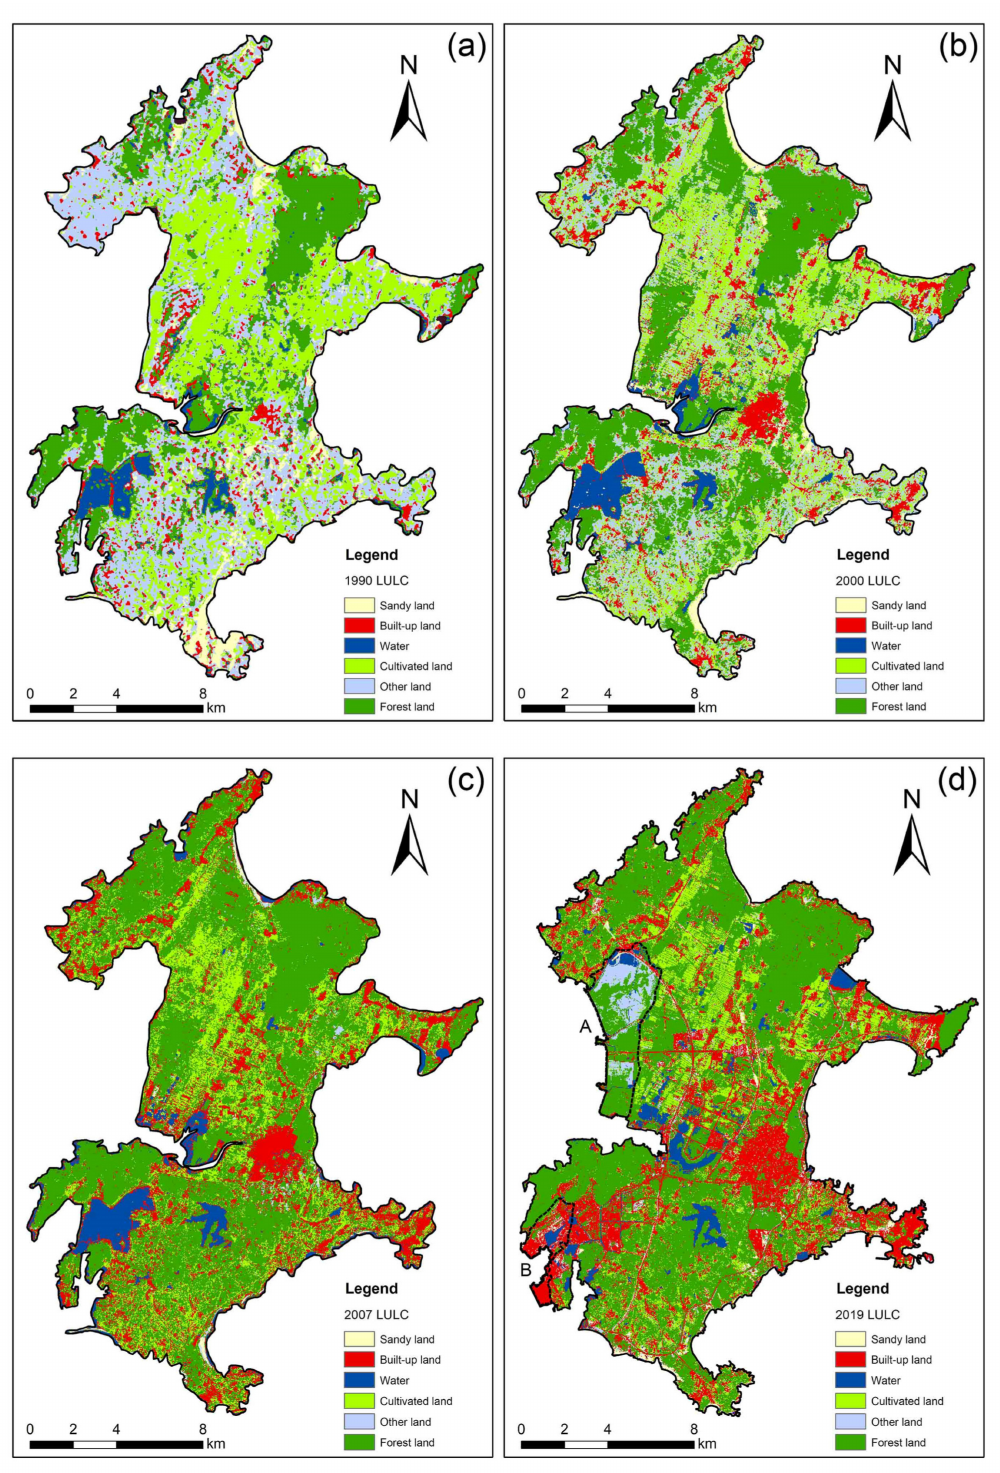
Figure 3. Land cover classification on Haitan Island: ( a ) 1990, ( b ) 2000, ( c ) 2007, and ( d ) 2019. A is the Xingfuyang area. A, B in ( d ) 2019 is the di ff erent area compared to 1990, 2000, and 2007, due to